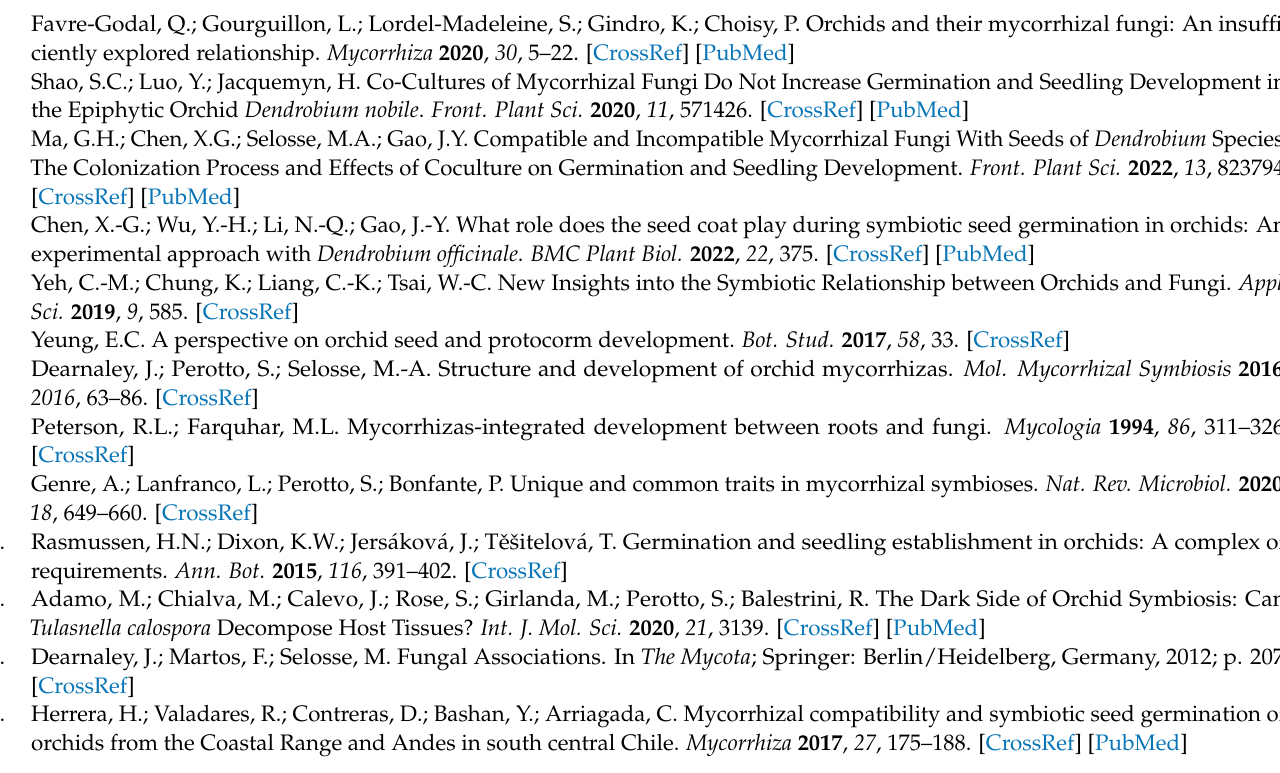
Table S3: The average fresh weight growth rate of protocorms on days 30, 60, and 90 of symbiosis; Table S4: Average dry weight growth rate of protocorms on days 30, 60, and 90 of symbiosis; Table S5: Average growth parameters of protocorms on day 90 of